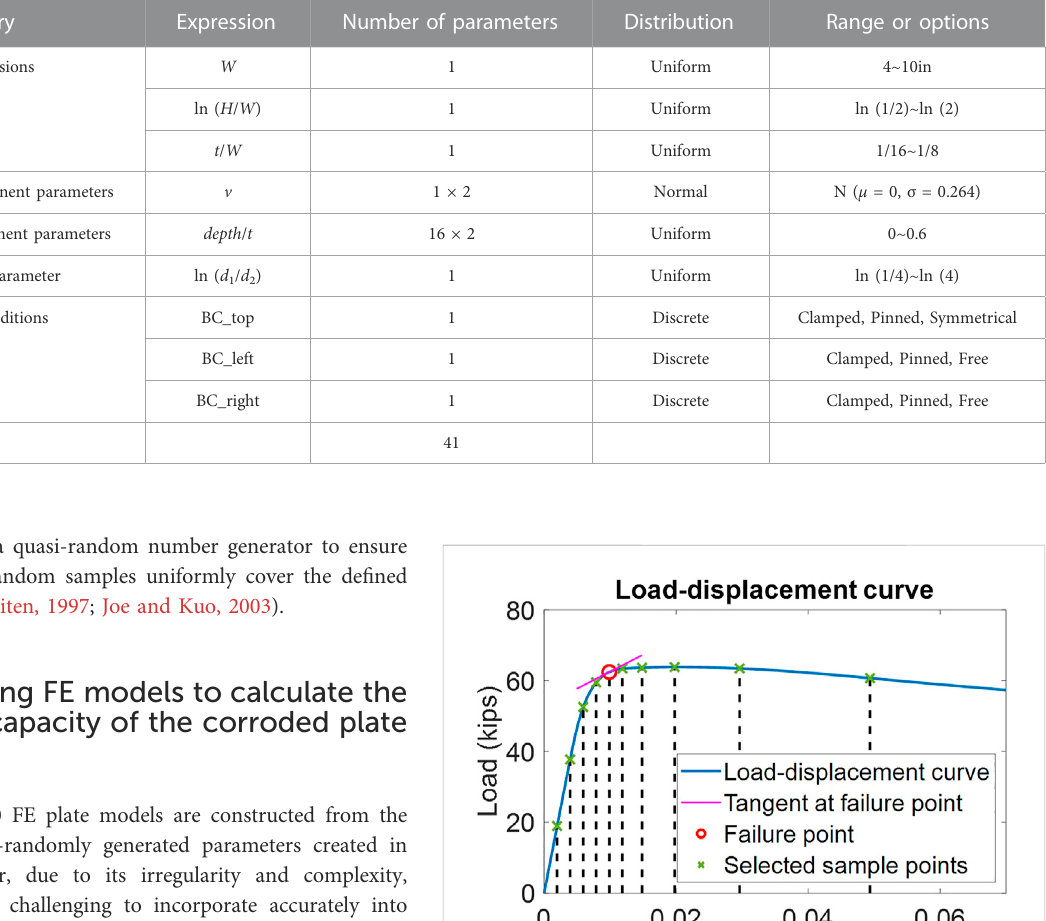
TABLE 2 Parameters required to generate each arti fi cial corroded plate model.